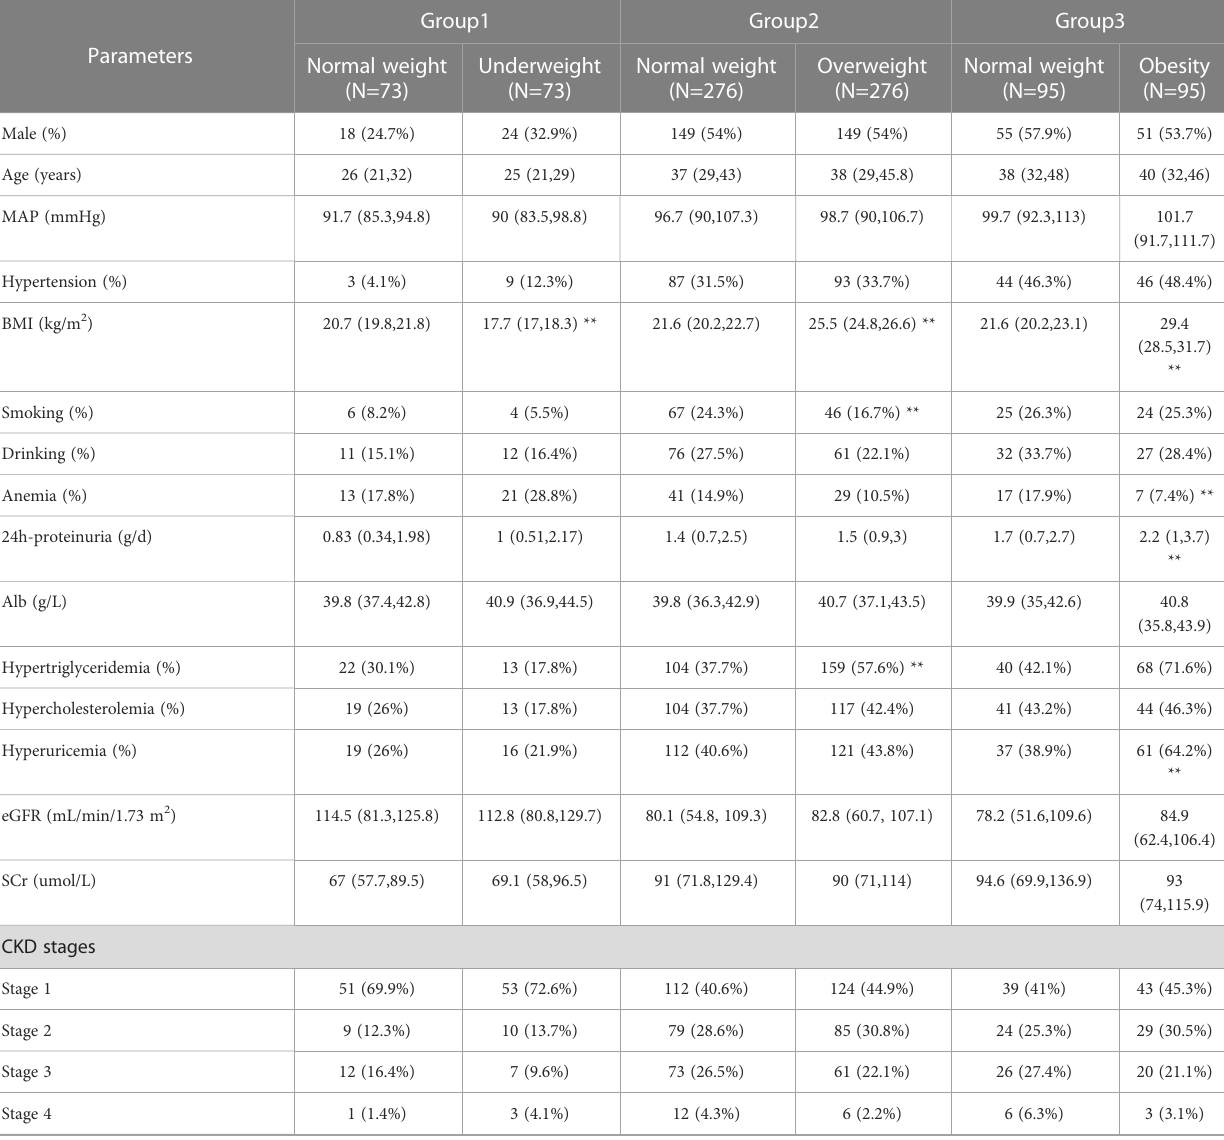
TABLE 3 Demographic and clinicopathological characteristics of matched groups.